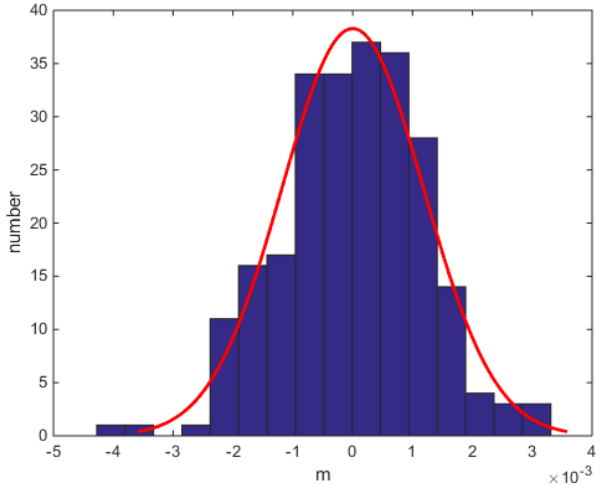
Figure 9. Histogram and normal distribution curve of the GPS-RTK measurement error.